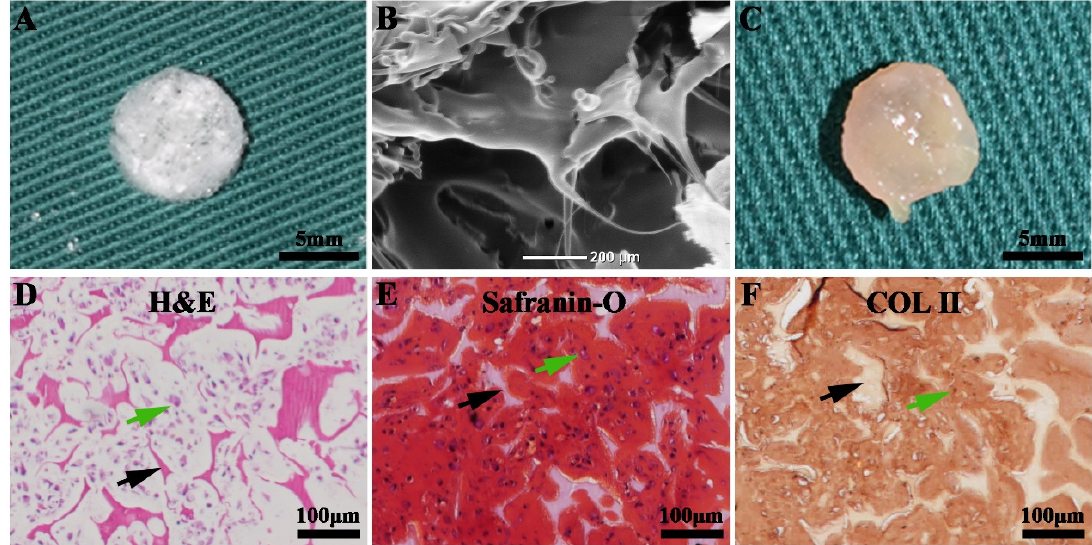
Figure 4. In vitro cartilage regeneration: Images ( A ) and scanning electron micrographs ( B ) of a porous poly(lactic-co-glycolic acid) (PLGA) scaffold. Images ( C ), hematoxylin-and-eosin staining ( D ), safranin-O staining ( E ), and COL II immunohistochemical staining ( F ) of the PLGA scaffold seeded with chondrocytes for 3 weeks. The green arrows indicate the cartilage-specific extracellular matrix (ECM). The black arrows indicate the PLGA scaffold.